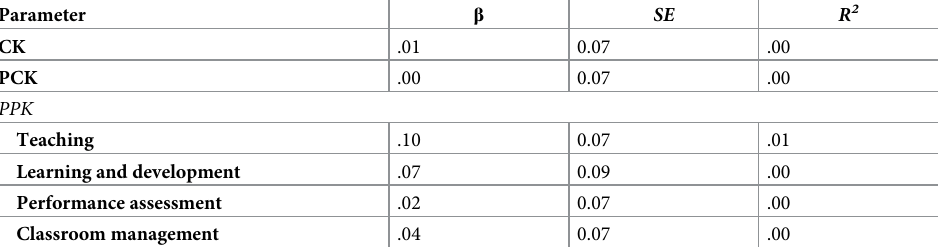
Table 2. Results of the regression analysis for the relationships between indicated dimensions of professional knowledge and enthusiasm for teaching.